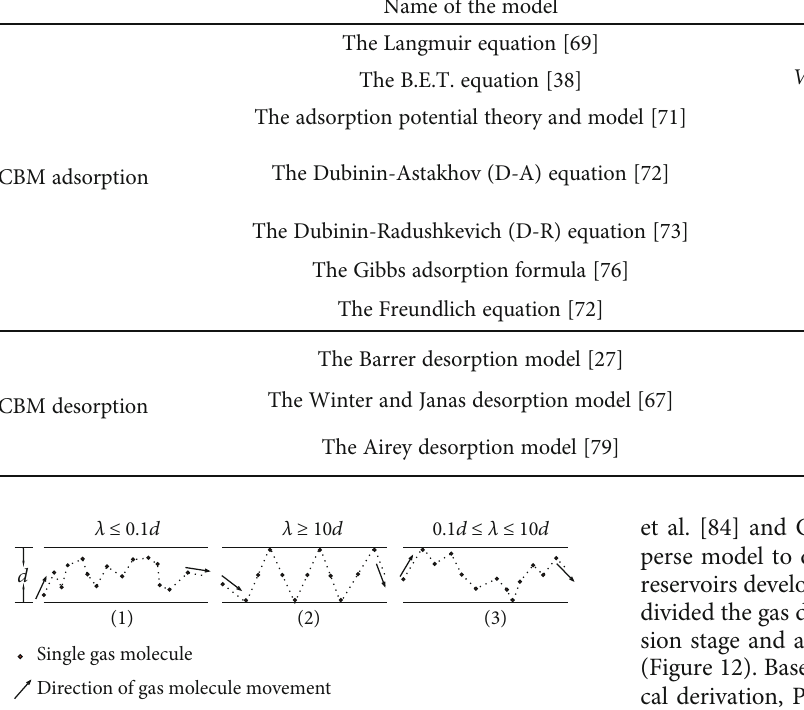
Figure 11: Three di ff erent modes of the CBM di ff usion process: (a) Fick ’ s di ff usion; (b) Knudsen ’ s di ff usion; (c) transitional di ff